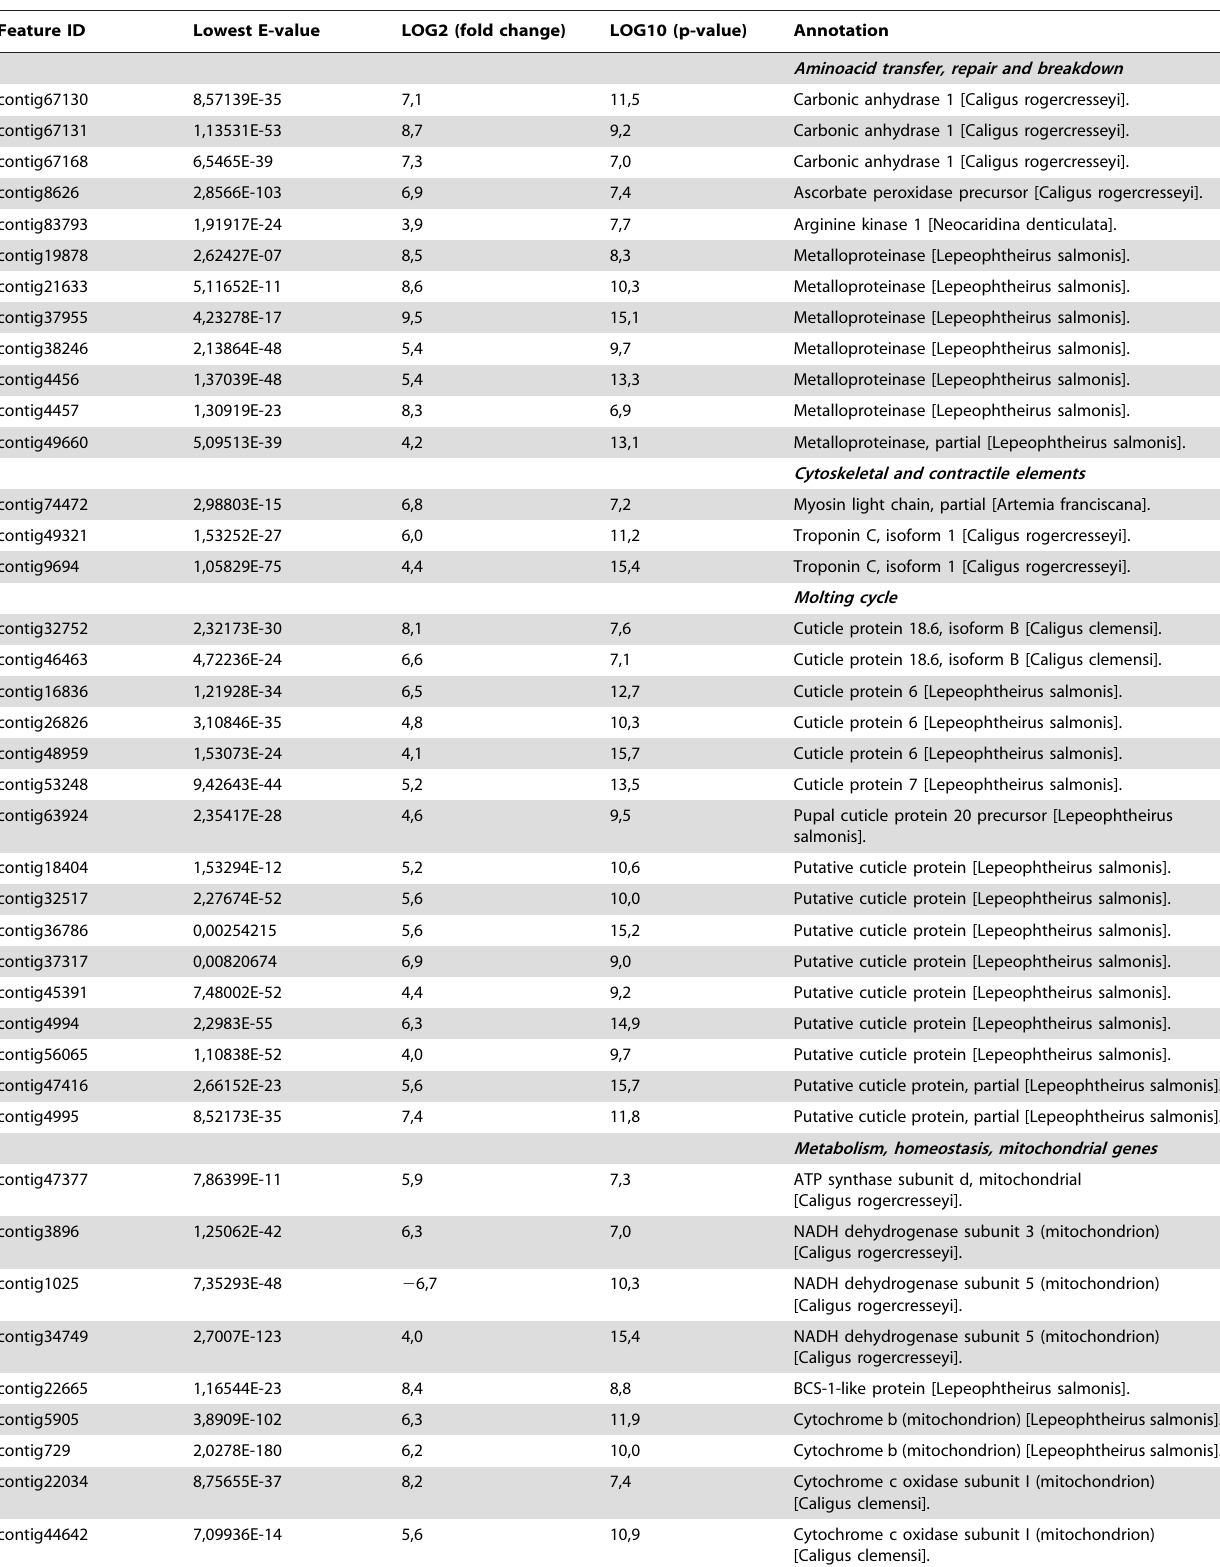
Table 3. Genes showing differential transcription expression between Copepodid/Nauplius I–II groups.